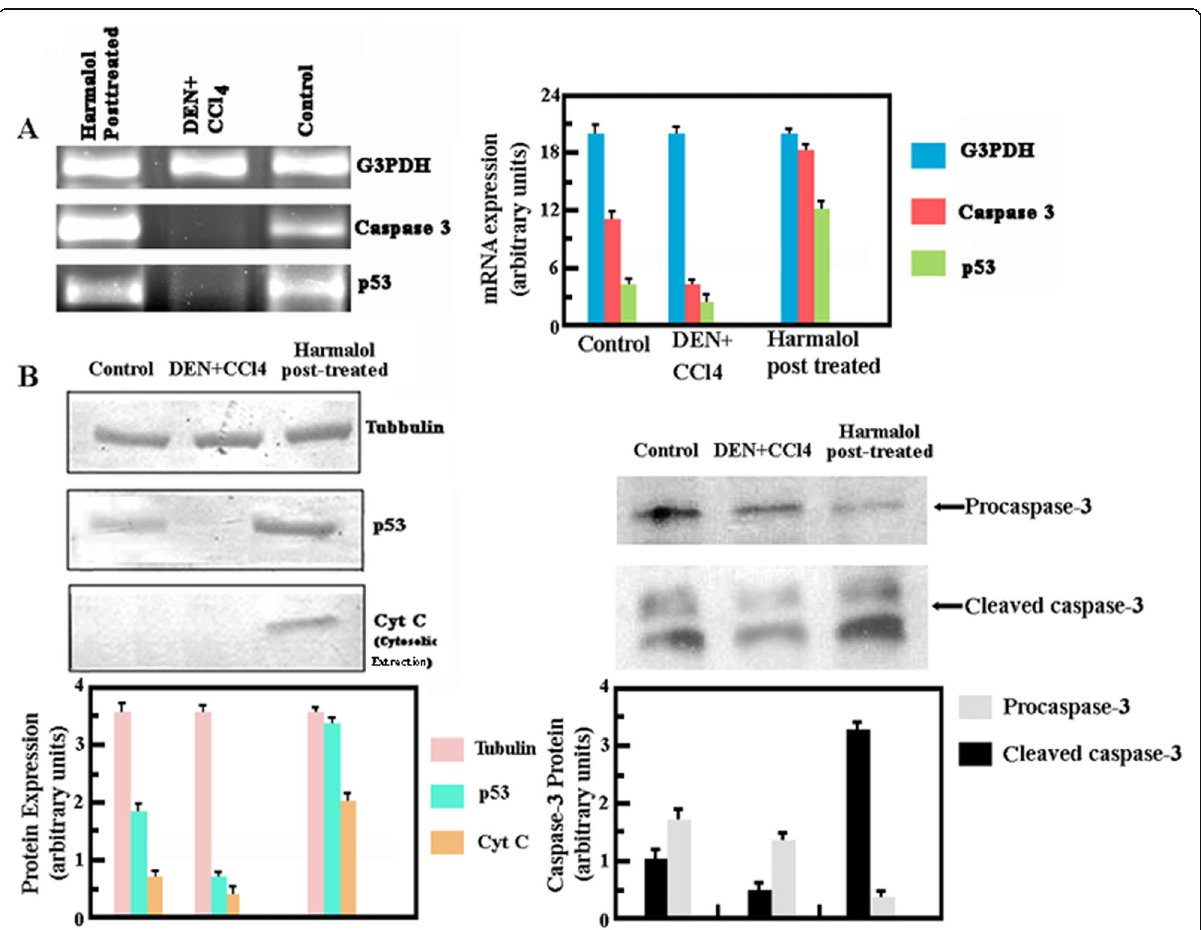
Fig. 8 a RT-PCR analysis conducted with a cytosolic fraction of caspase 3 and p53 activation G3PDH was used as an internal control for normalization of equal loading. b Western blot analysis of caspase 3, p53, and cytochrome c from whole protein extracted from the liver of the control, DEN+CCl 4 -induced, and post-treatment with harmalol of HCC-induced mice. Tubuline was used as loading control. Bar graphs represent the quantification of each marker